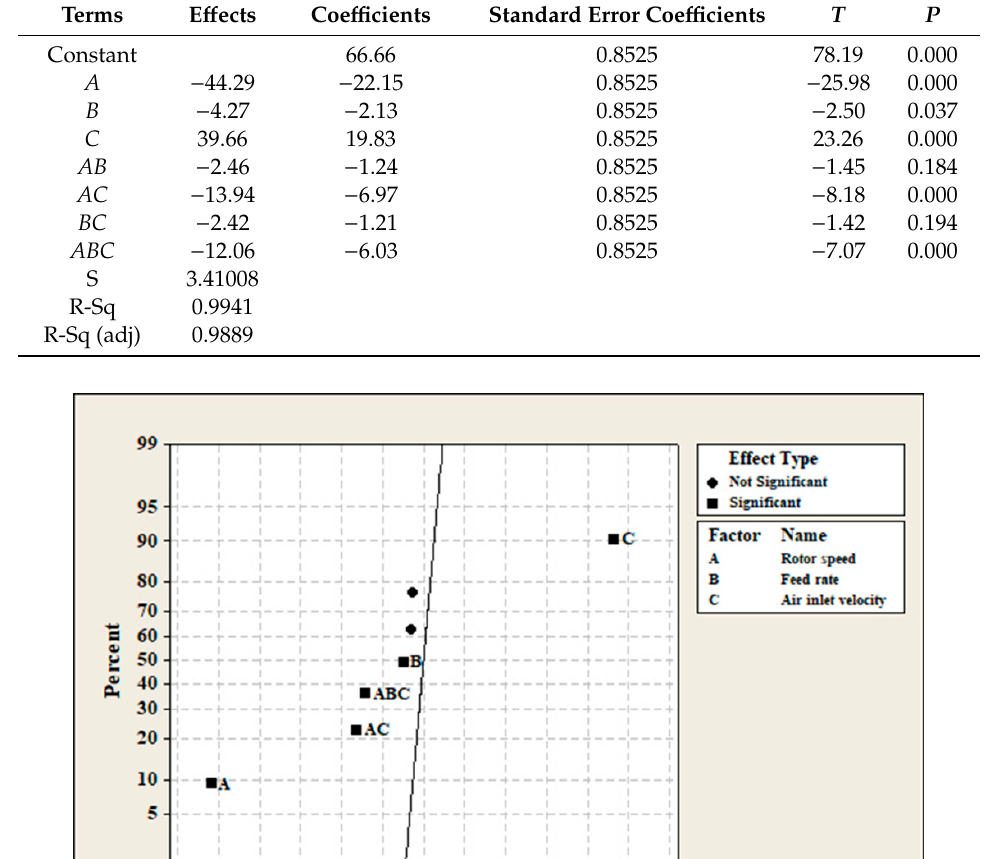
Table 4. Statistical parameters for 2 3 -factorial design of experiments.